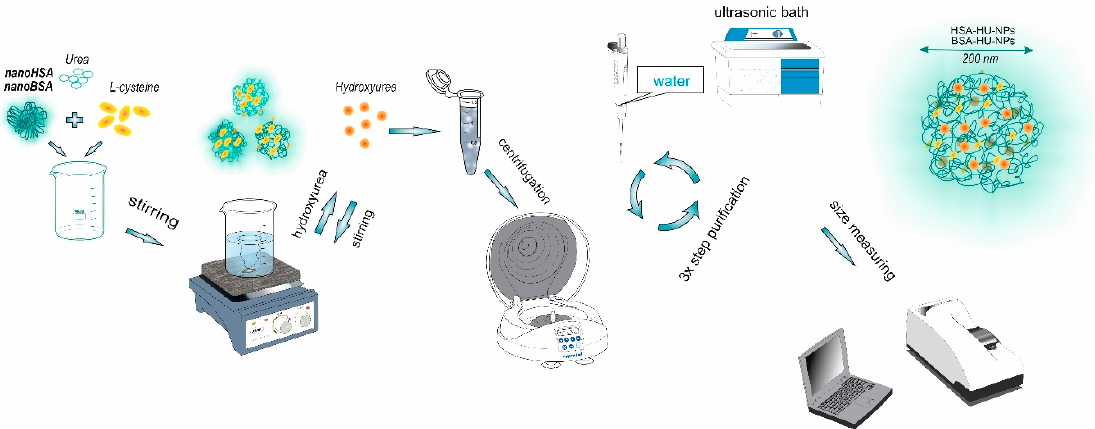
Figure 1. The schematic illustration of the method used to prepare HU-loaded protein nanoparticles.